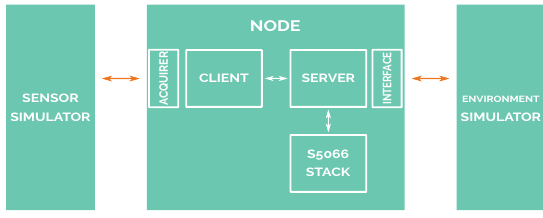
Figure 4. Software-in-loop